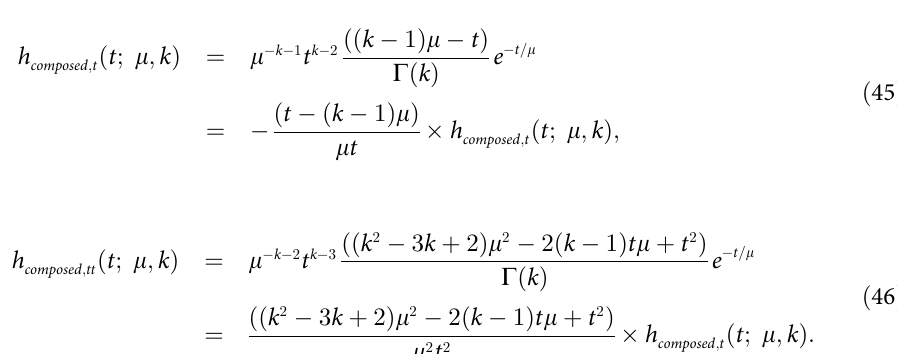
ffiffiffiffiffiffiffiffi p 1 = 7 .